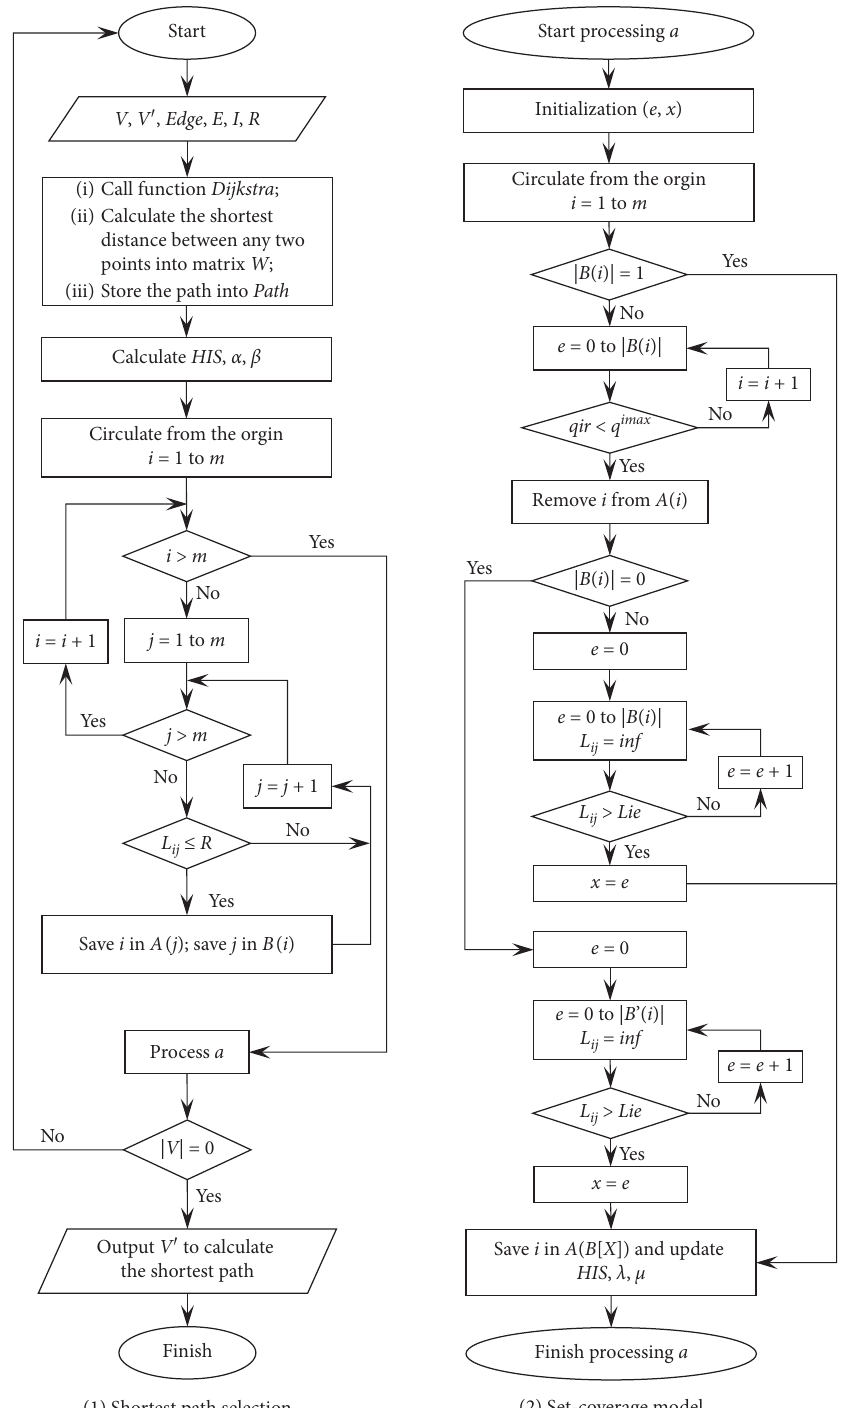
Figure 1: Algorithm flow